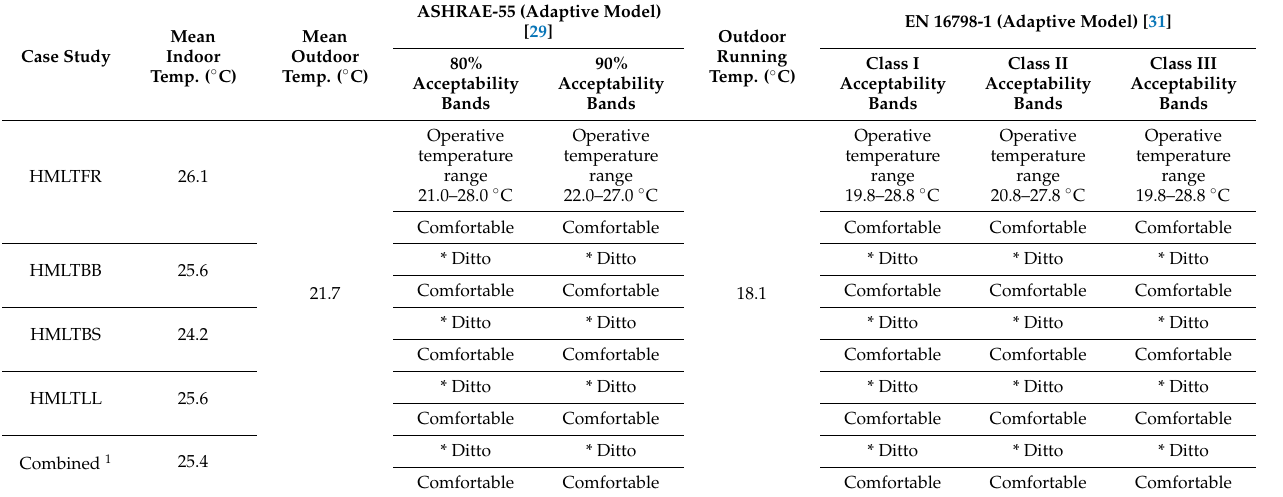
Table 6. Summary of the average variables and thermal indices in the case studies.